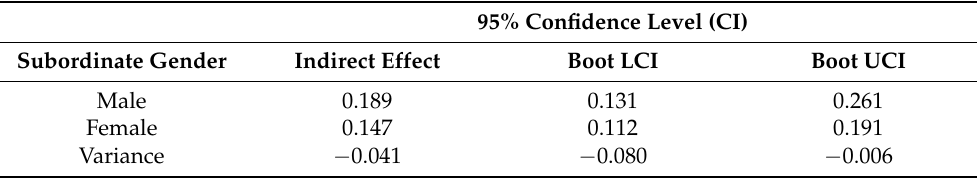
Table 4. The moderated mediation model